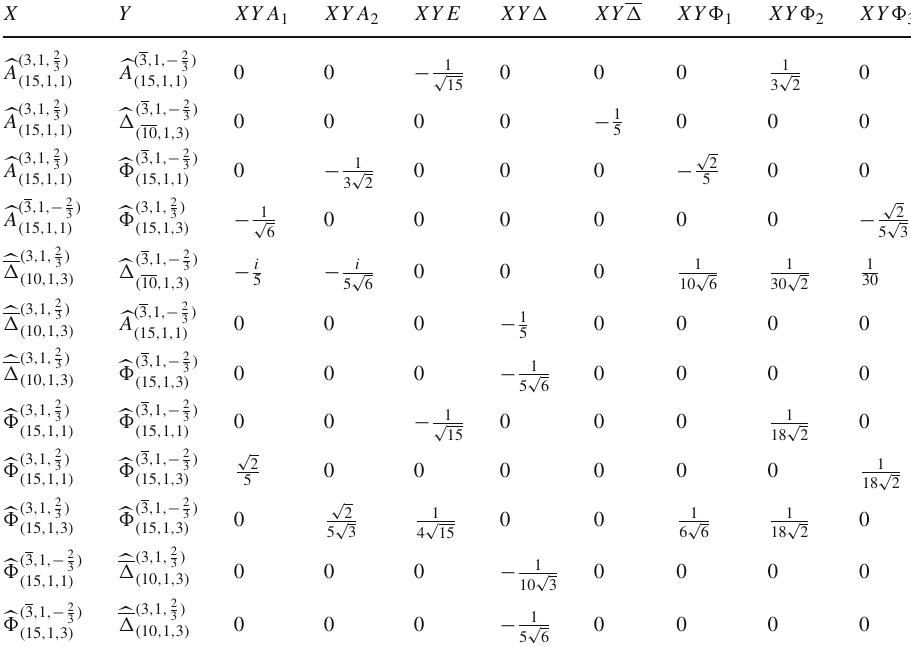
Table 4 CGCs for the Goldstones (3, 1, 2